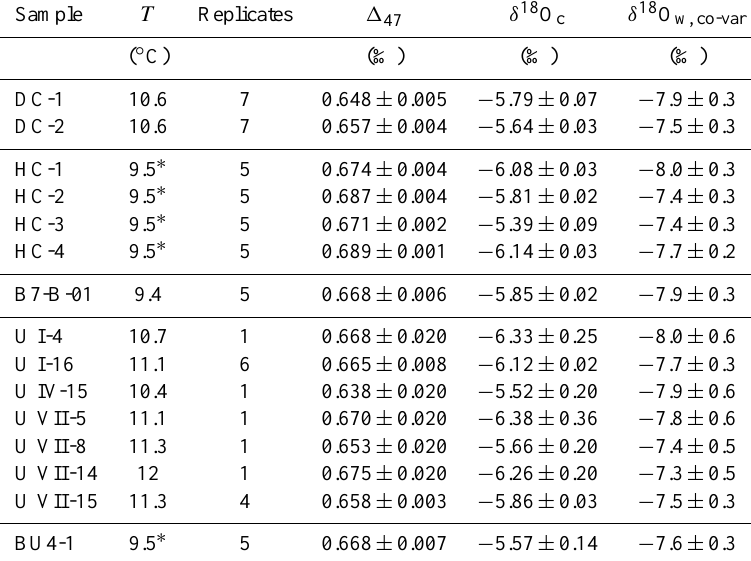
Table 1. Clumped isotope 1 47 , calcite δ 18 O c (VPDB) and reconstructed drip-water δ 18 O w, co-var (VSMOW) of modern calcite precipitates from Bunker Cave and adjacent caves (BU = Bunker Cave, DC = Dechen Cave, HC = H¨uttenbl¨aserschacht Cave, B7 = B7 Cave). Samples labeled U are precipitates on watch glasses from Bunker Cave. T is either the in situ monitoring temperature or the 1961–1990 ambient air-temperature mean (labeled with